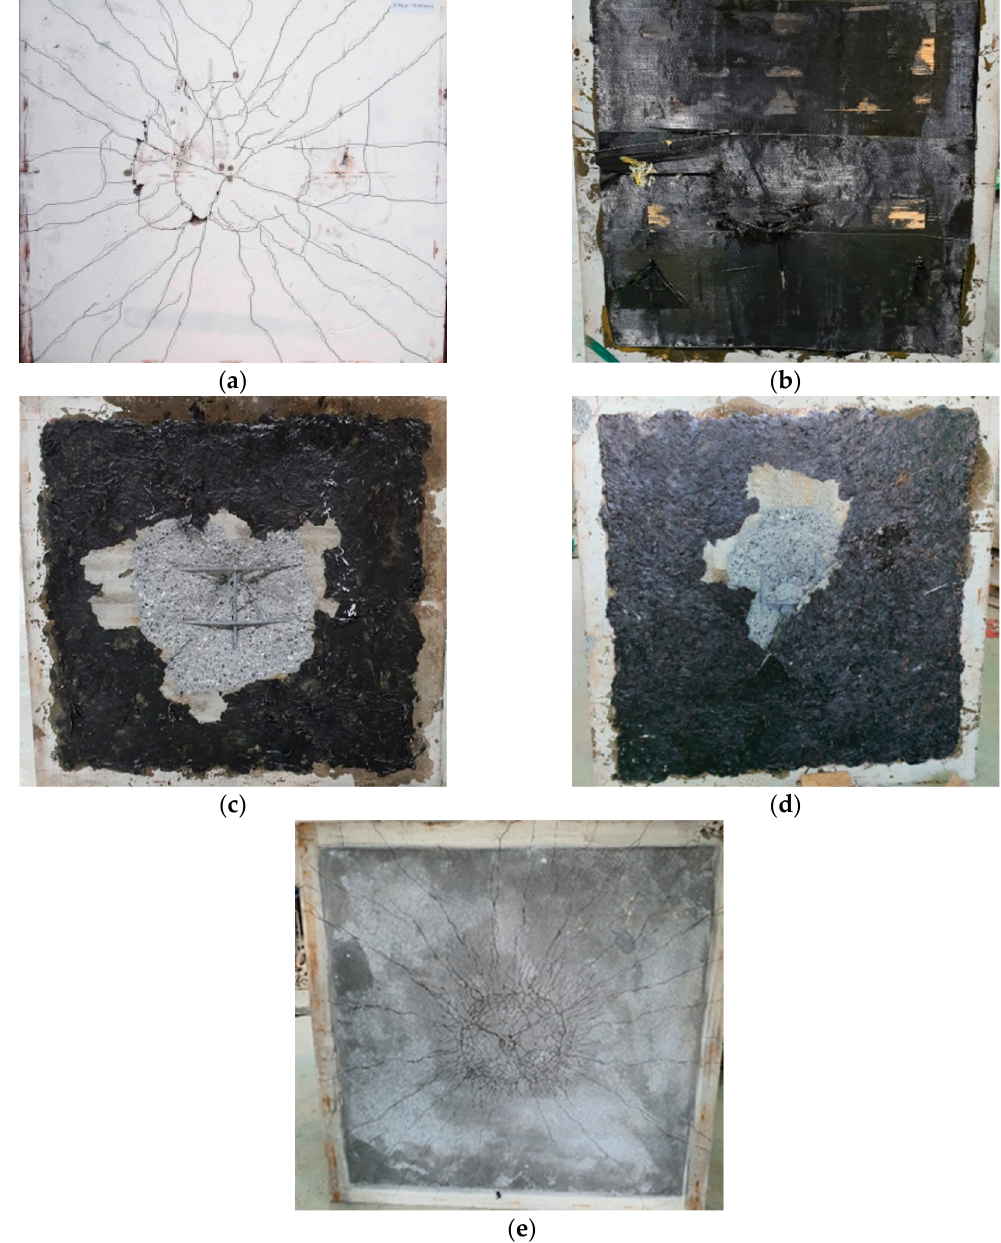
Figure 7. Failure modes of tested specimens of bottom side: ( a ) NC-NF; ( b ) NC-F; ( c ) NC-F-S; ( d ) NSC-F-S; ( e ) NSC-NF.